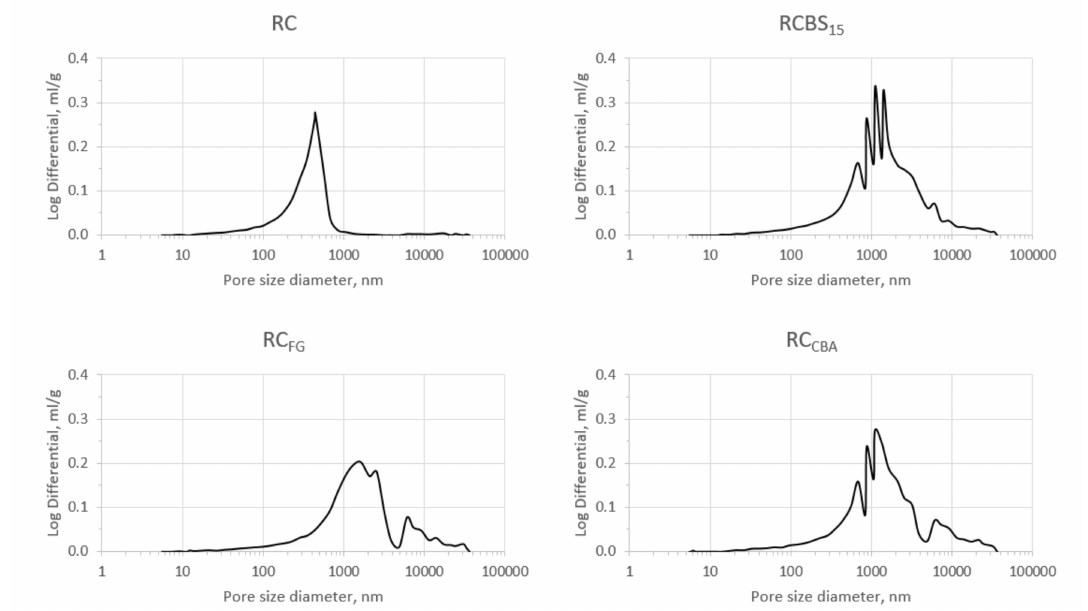
Figure 5. Pore size distributions from mercury intrusion analysis for RC, RCBS 15 , RC FG , and RC CBA